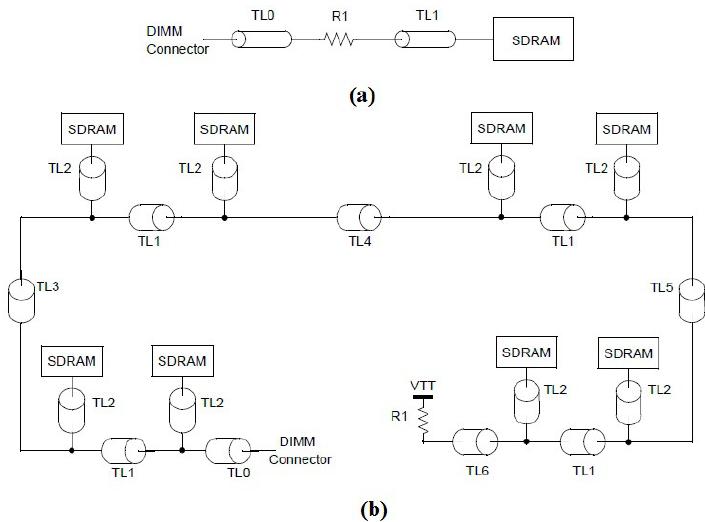
Figure 15. Nets routing configurations of DDR4 module: ( a ) DQ nets (point to point); and ( b ) address nets (point to multi-points (layers))